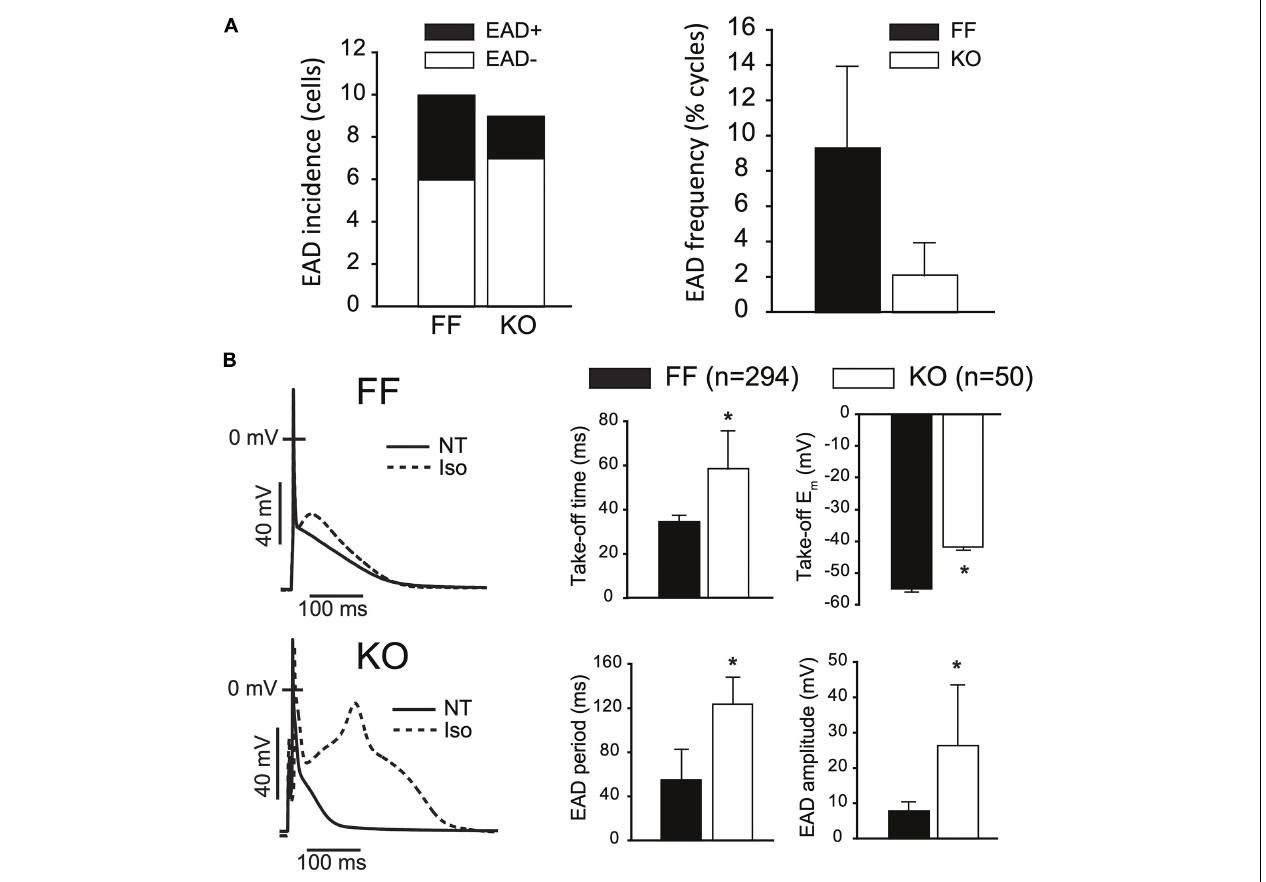
FIGURE 4 | SERCA2-KO myocytes are not more susceptible to EADs but exhibit altered EAD dynamics. (A) KO cells ( n = 9) did not exhibit a higher incidence (left panel: 2/9 KO cells vs. 4/10 FF cells, p > 0.01), or frequency (right panel: 50/3037 total KO cycles vs. 293/2593 total FF cycles, p > 0.01) of EADs relative to FF ( n = 10). (B) However, KO EADs exhibit altered dynamics as indicated by increased amplitude, period and time to initiation, and reduced (more positive) take-off potentials. All panels: * p < 0.05. Data are means ±